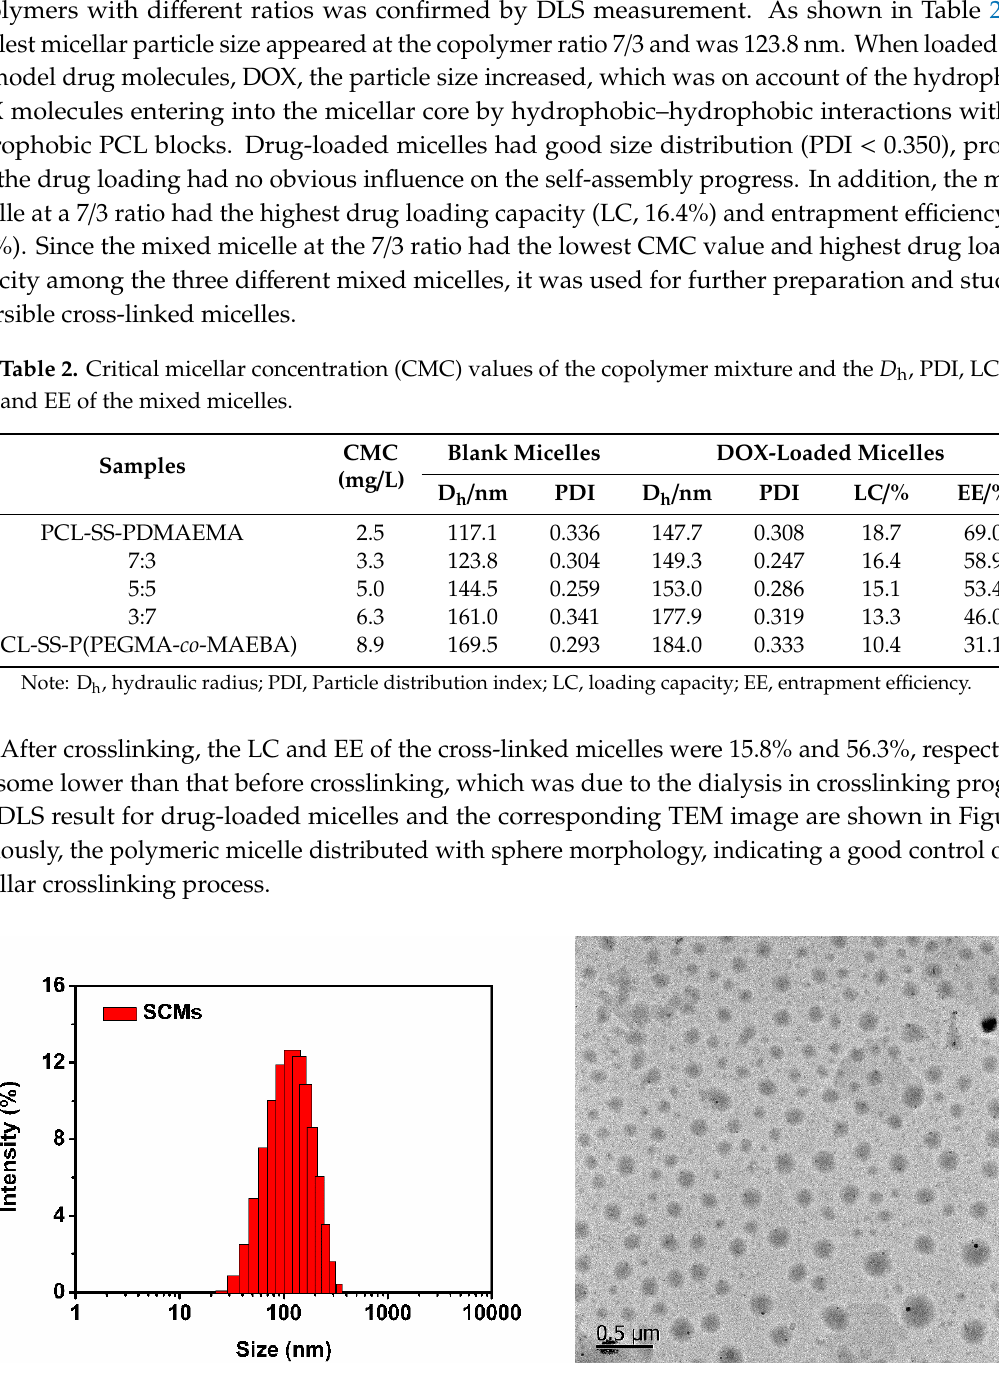
Figure 6. DLS results and TEM image of the cross-linked mixed micelles with DOX loading.